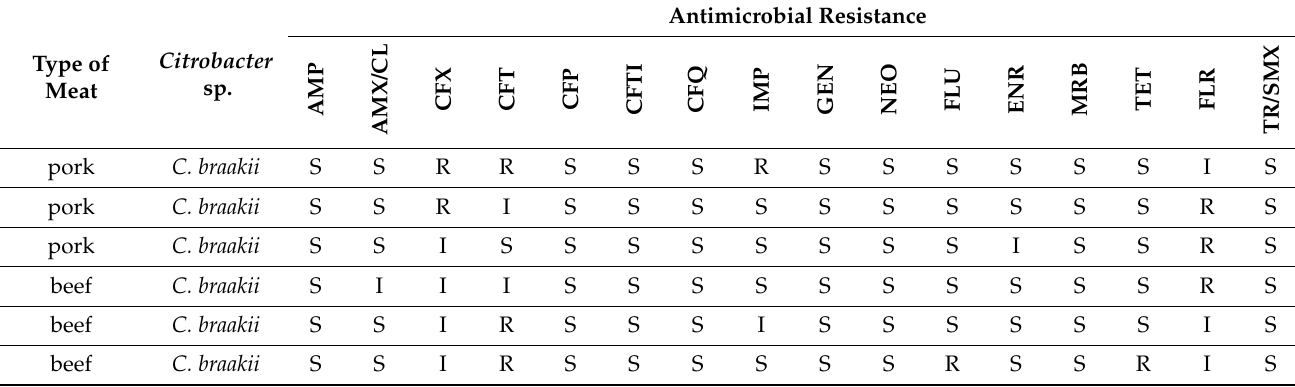
Table 3. Antimicrobial resistance common to the variously identified Citrobacter braakii isolated from samples of pork and beef.